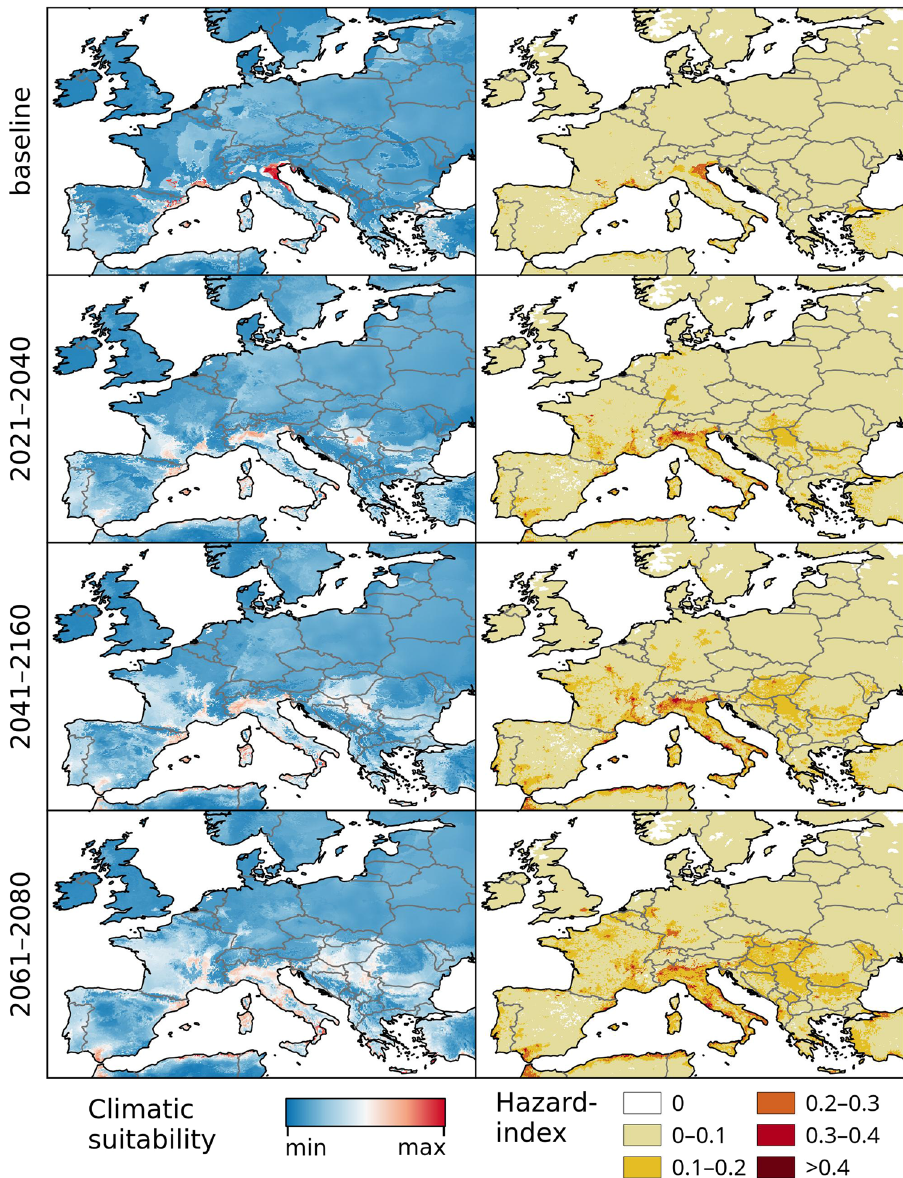
Figure 5. Chikungunya under the baseline and RCP 8.5 climate change scenarios in Europe. Left: Climatic suitability, right: hazard index. Climate change scenarios represent the mean model output obtained through the 5 GCMs. Climatic suitability output is scaled to the over-all global minimum (0) and maximum (0.623) values observed in any model. Maps were generated using the “raster” package in R 3.3.2 (https://www.r-project. org/) and QGIS 2.8.1